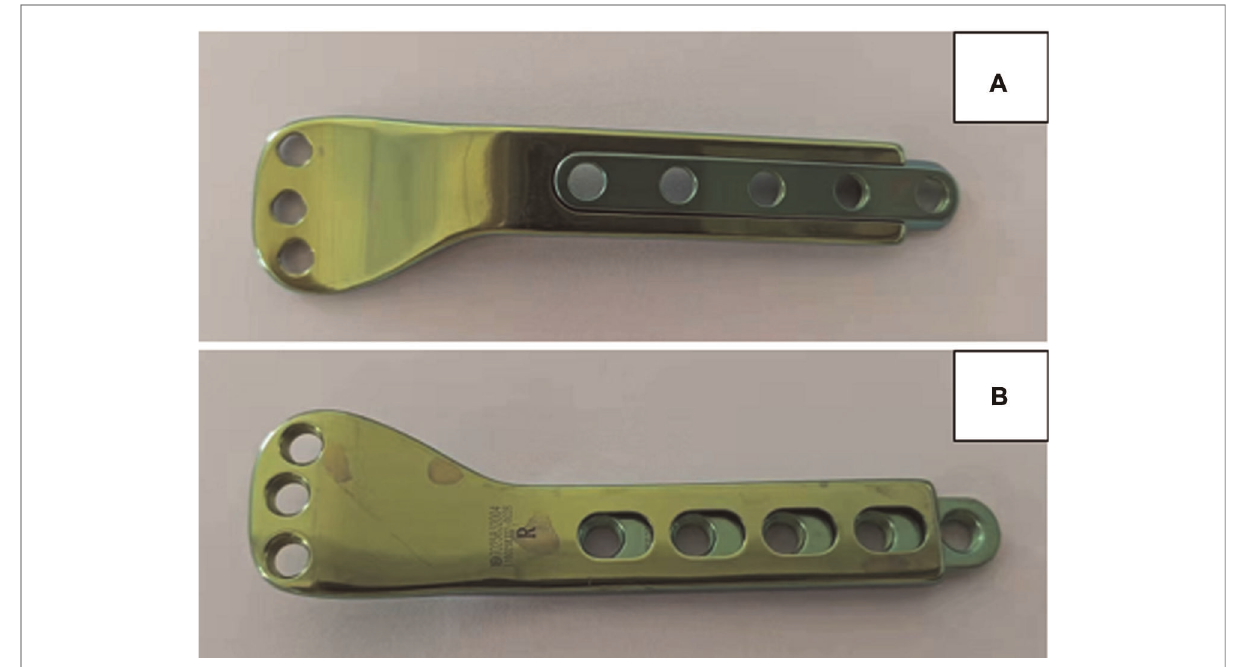
FIGURE 1 Images of the pediatric physeal slide-traction